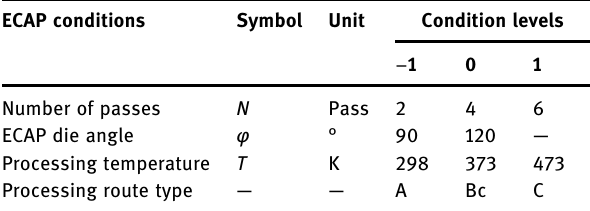
Table 1: ECAP parameters and corresponding levels ECAP conditions